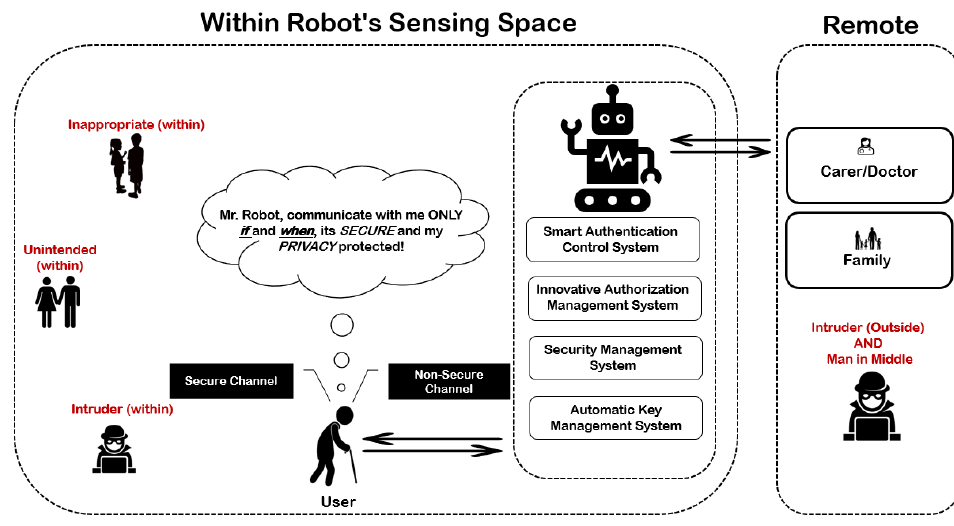
Figure 3. Threat Modelling of Single User AMRSys.